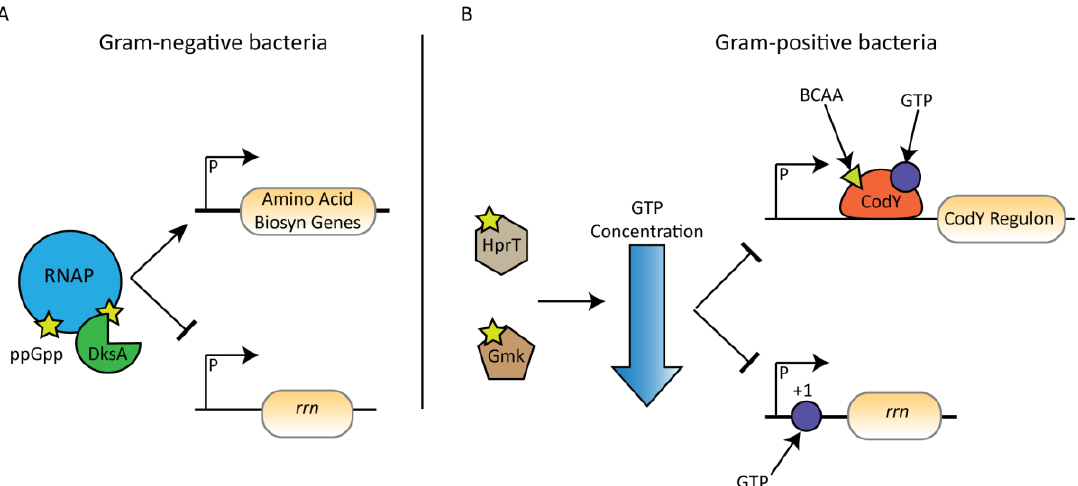
Figure 5. The effect of the stringent response on transcription in Gram-negative and Gram-positive bacteria. ( A ) In Gram-negative organisms, (p)ppGpp (yellow) and DksA (green) bind to RNA polymerase to alter the transcription of amino acid biosynthesis genes (activated) and rRNA genes (repressed). ( B ) In Gram-positive bacteria (p)ppGpp bind to and inhibit multiple enzymes involved in GTP synthesis. This coupled with the decrease in branched chain amino acid (BCAA) levels during the stringent response results in a derepression of the CodY regulon as well as a decrease in transcription of rrn and other genes with a G residue at the +1 site.